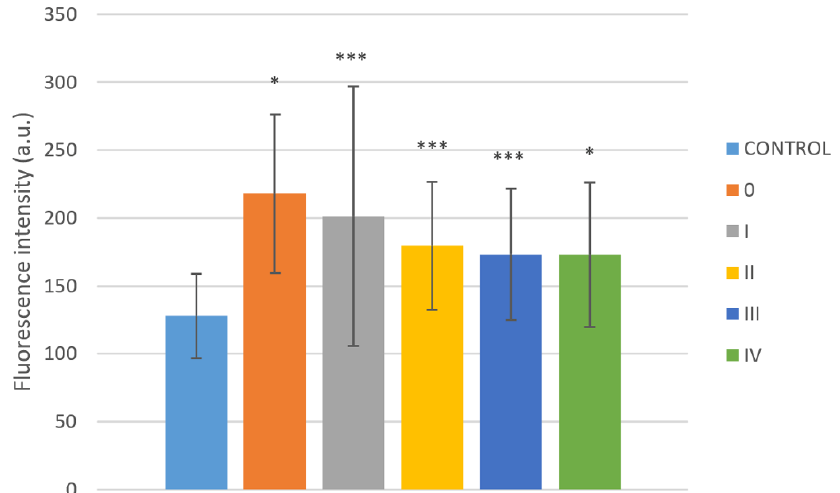
Figure 5. Fluorescence intensity in various clinical stages. Statistically significant difference is re- lated to the control group. Values are expressed as mean ± SD. * indicates p < 0.05 and *** indicates p < 0.001.